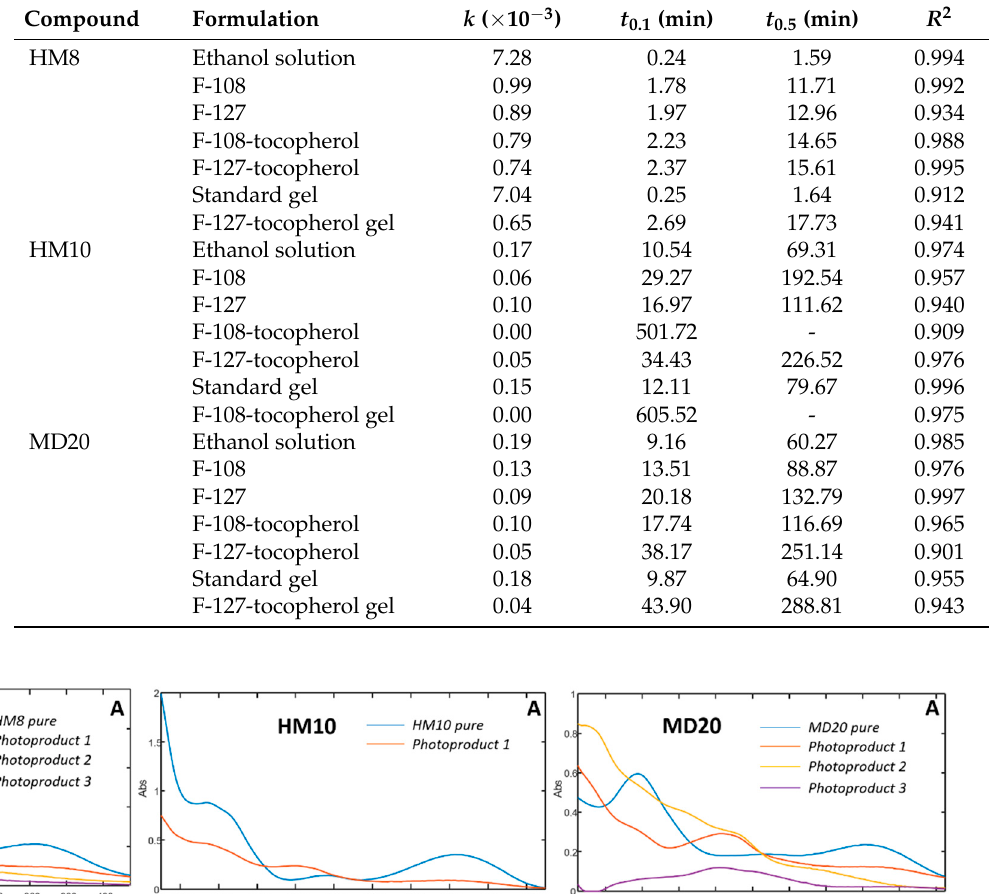
Table 3. Degradation kinetic parameters calculated for the HM8, HM10 and MD20 formulations.